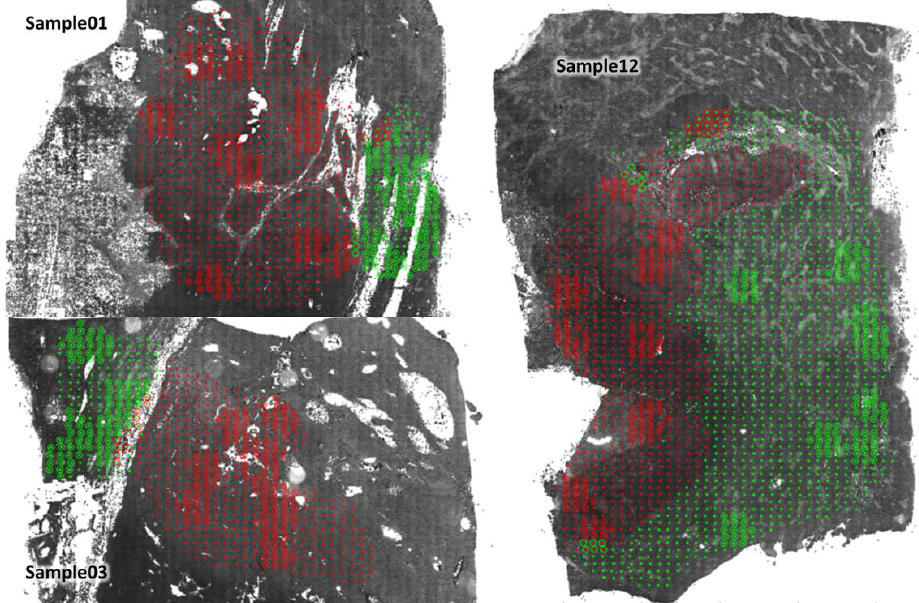
Figure 3. A total of 10 randomly selected virtual biopsies each from the primary tumour (PT) and the non-tumour liver (NTL) tissues with a size of 16 fields of view (16 × 0.15 mm 2 ) of 3 HCC patients. Green dots indicate NTL and red dots PT according to the pathologists’ assignment. The field of view classification for the virtual biopsies based on the cancer score of the U-net corresponds to the pathologists’ assignment if the circle has the same colour as the dot in its centre. Table 3. Comparison of cells located in the hepatocellular carcinoma primary tumour (PT) tissues and in the adjacent/surrounding non-tumour liver (NTL) tissues. For this analysis, 10 randomly selected regions of interest, i.e., virtual biopsies, each with a size of 16 fields of view from both PT and NTL per sample ( n = 12) were used to determine the mean percentage of “positive” cells for each marker and marker combination. Comparison with the Mann–Whitney U test between 978,069 cells located in PT and 765,976 cells in NTL. Statistically significant differences are marked with asterisks. Lymphocyte Panel PT NTL p -Value CD3 CD4 CD8 FoxP3 PD-L1 Mean (SD) (%) Mean (SD) (%)